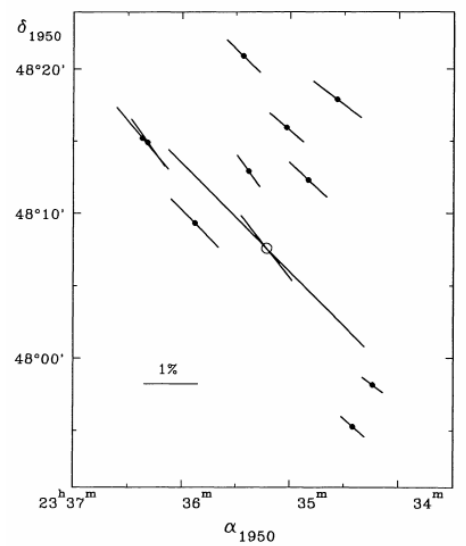
Figure 6. Polarization map of the BM and as well as the neighborhood from [81,84]. Two values of the star polarization are given: at the bright state and at the deep minimum. Credit: Grinin et al. 1995, A&AS, 112, 457, reproduced with permission ©